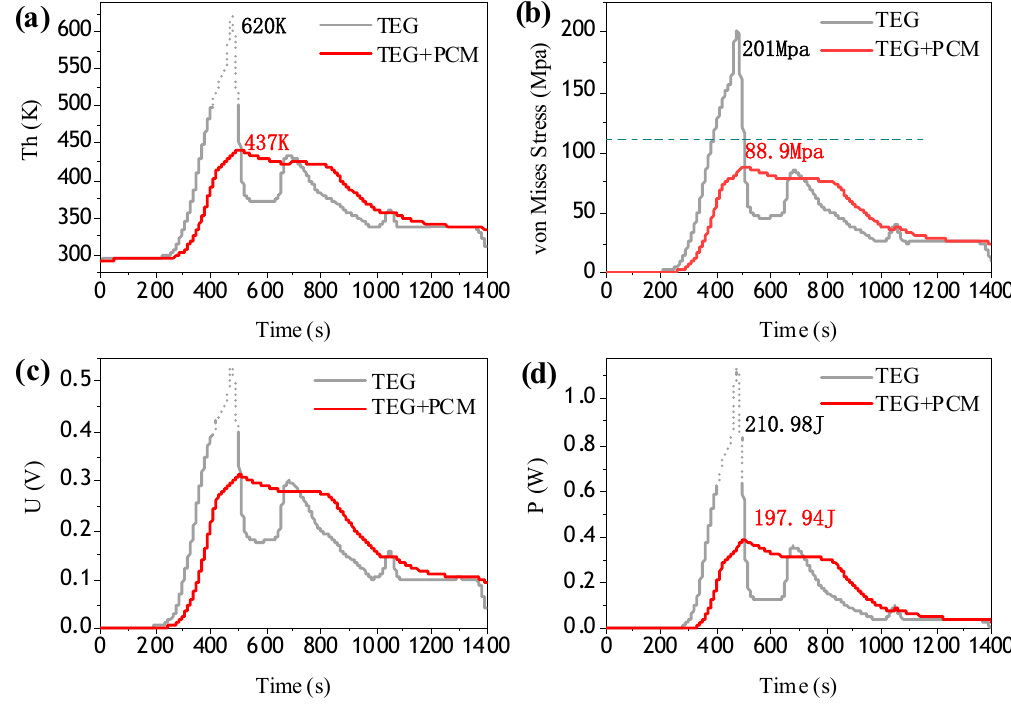
Figure 7. ( a ) Temperature curve; ( b ) Stress curve; ( c ) Voltage curve; ( d ) Power curve.